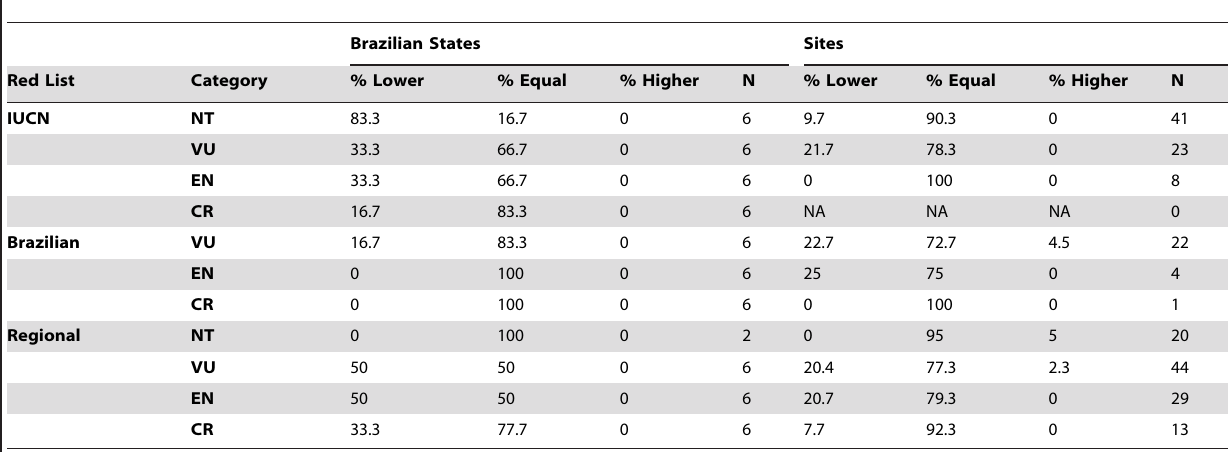
Table 2. Percentage of analyzed Brazilian States and sites with threatened birds in categories of the IUCN, Brazilian and respective States Red Lists which had values of observed phylogenetic diversity lower, equal or higher than expected by chance (see Supplementary Material for more